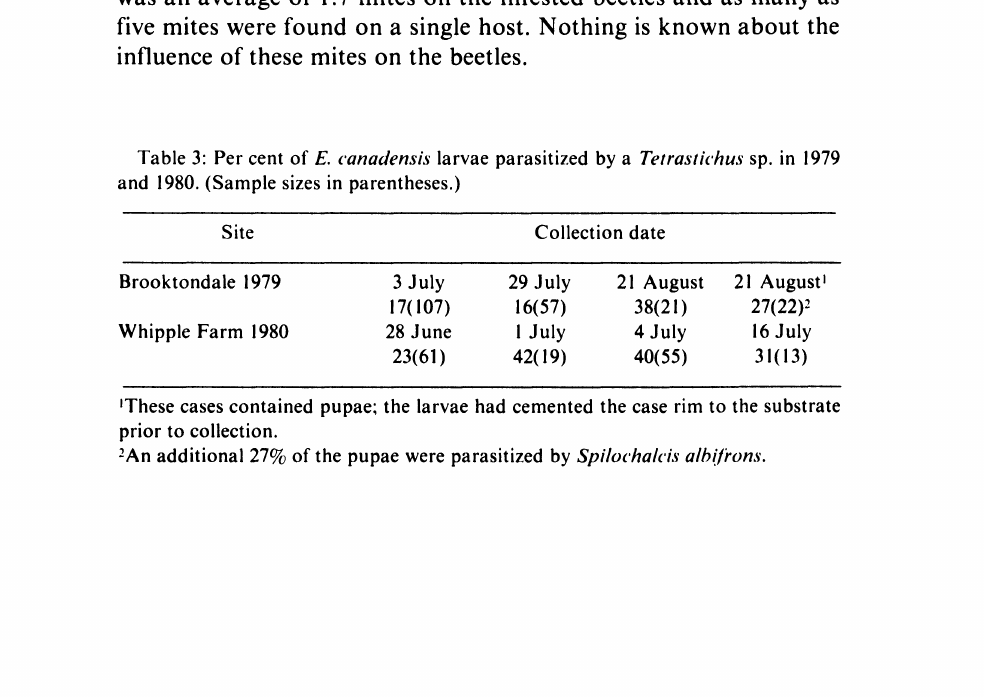
Table 3: Per cent of E. canadensis larvae parasitized by a Tetrastichus sp. in 1979 and 1980. (Sample sizes in